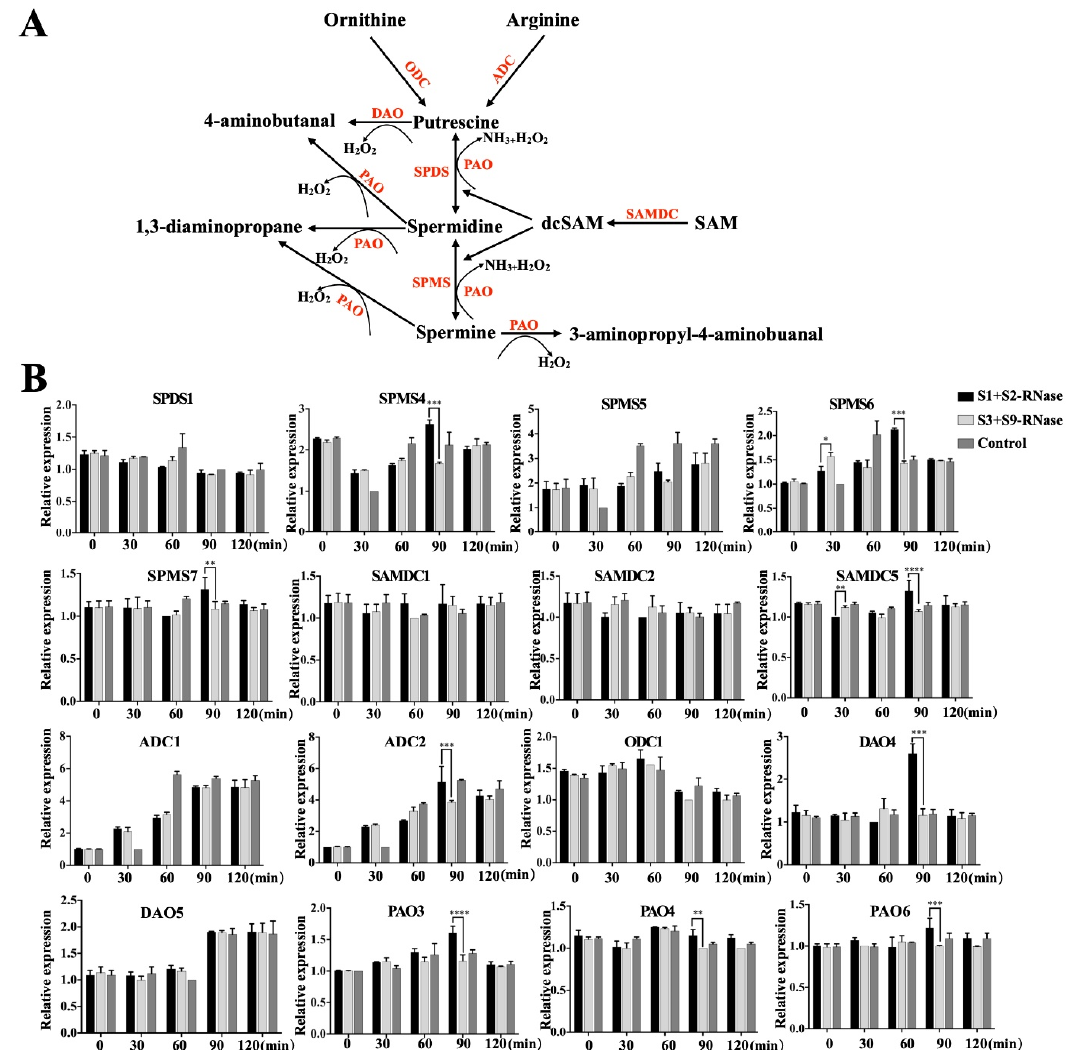
Figure 2. Expression of key genes in the polyamine biosynthetic and oxidative pathway. ( A ) A schematic diagram on